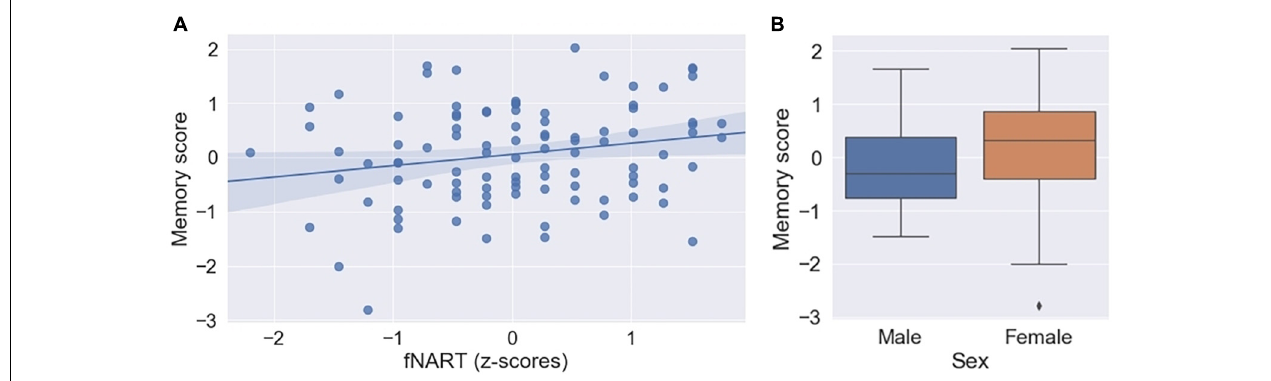
FIGURE 2 | (A) Scatter plot displaying association between episodic memory and fNART ( N = 101). Regression was used for visual display only and not as a substitute for full GLMM statistics. (B) Box plot visualizing episodic memory score according to sex ( N = 101).